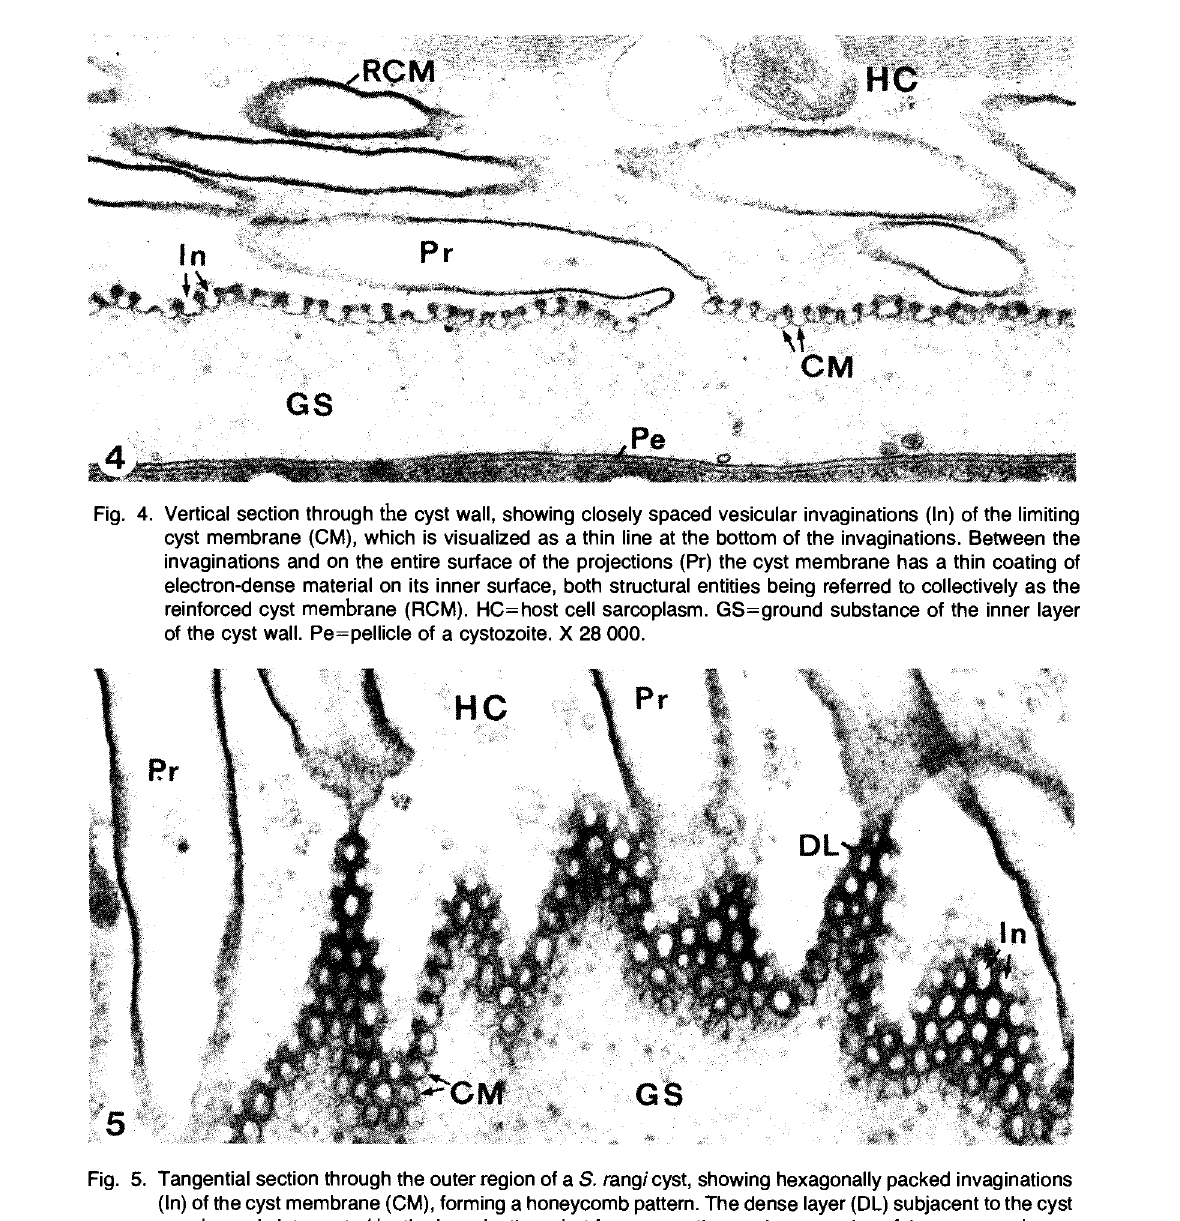
Fig. 5. Tangential section through the outer region of a S. rangi cyst, showing hexagonally packed invaginations (In) of the cyst membrane (CM), forming a honeycomb pattern. The dense layer (DL) subjacent to the cyst membrane is interrupted by the invaginations, but forms a continuous inner coating of the cyst membrane on the projections (Pr). GS=ground substance at the periphery of the cyst. HC=host cell sarcoplasm. X 37